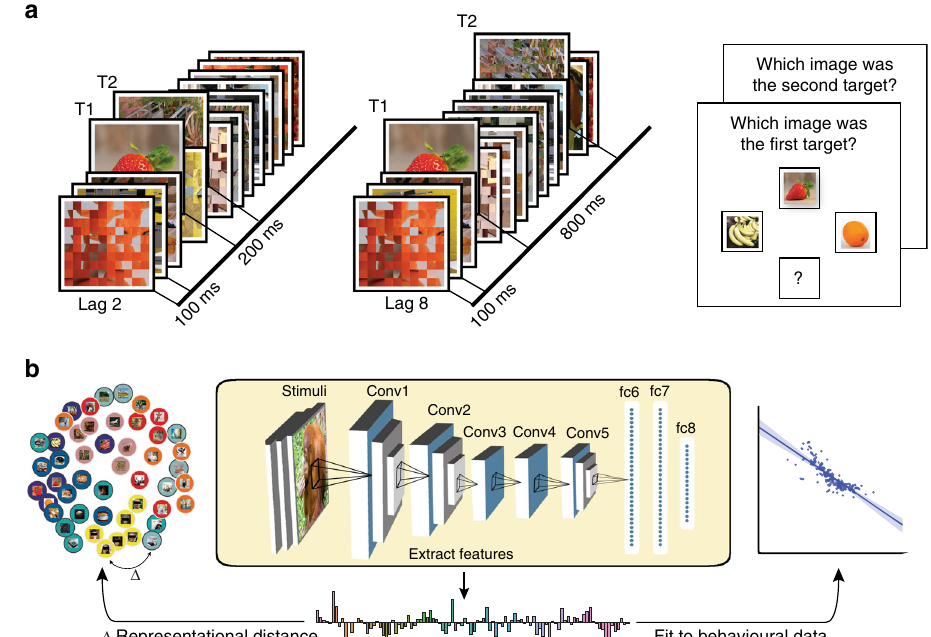
Fig. 1 Modulating conscious access using the Attentional Blink Paradigm. Due to copyright reasons, all photos except for the faces (which were photographed by one of the authors but have been anonymised) have been replaced by representational images. Eye regions are occluded above in the images to protect privacy but were not occluded in the experiment. a We presented a rapid serial visual presentation to participants, with two targets (T1 and T2) following each other within a stream of distractors. On the left, the second target (T2) is shown 200 ms after the fi rst target (T1), and on the right, 800 ms after the T1. In every trial, participants had to detect and later recall both T1 and T2 targets. b We used a deep convolutional neural network (DCNN; yellow insert; 5 convolutional layers and 3 fully connected layers) to model the stimulus representational geometries (left) and predict our participants ’ behaviour (right). The visual stimuli were fed into the DCNN, providing a hierarchical representation for each image. These unit activations were then analysed layer-by-layer and used to predict